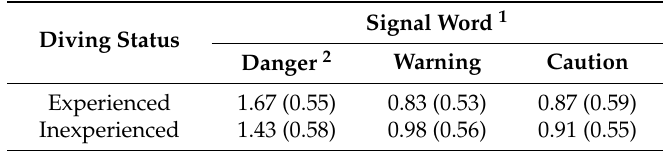
Table 1. Extent of understanding of signal words (possible range: 0–2.0) as a function of diving